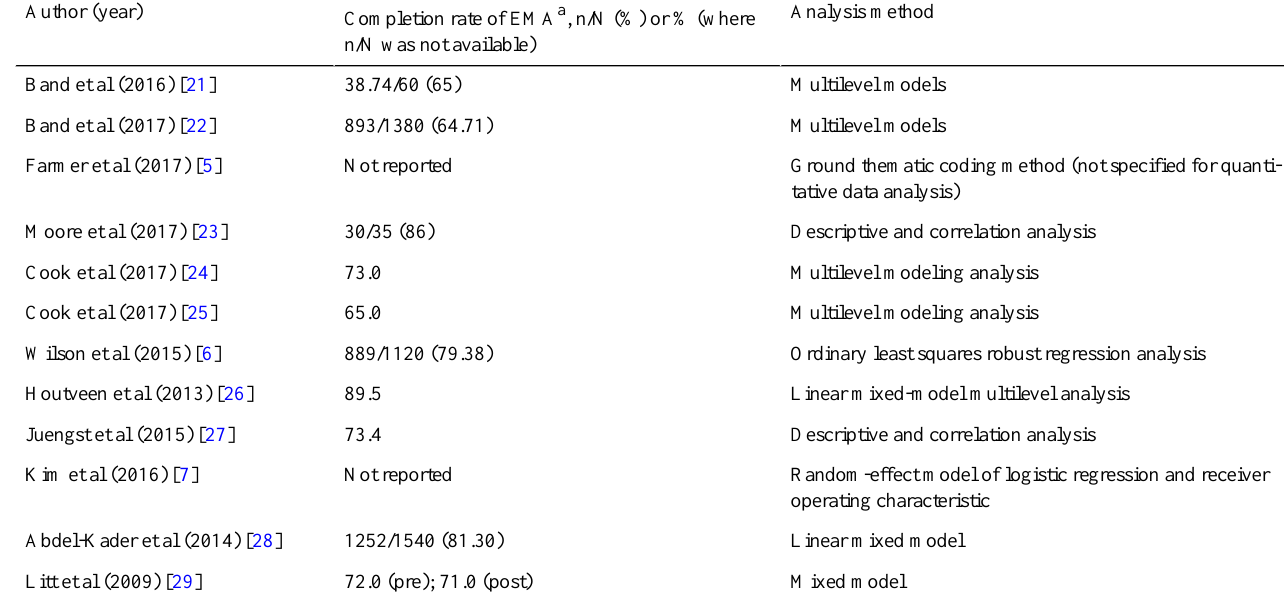
Table 3. Completion rate and method used to analyze momentary